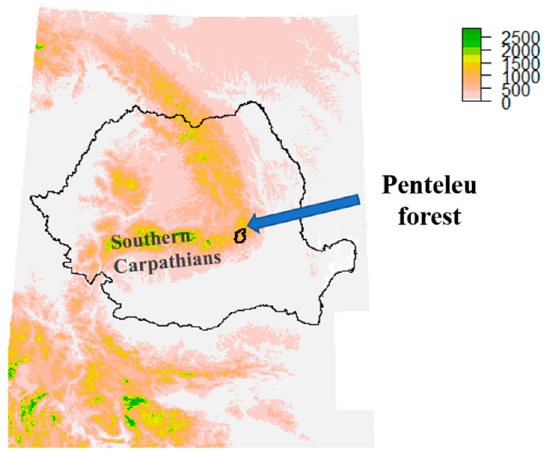
Figure 1. Study area location in Southern Carpathians.